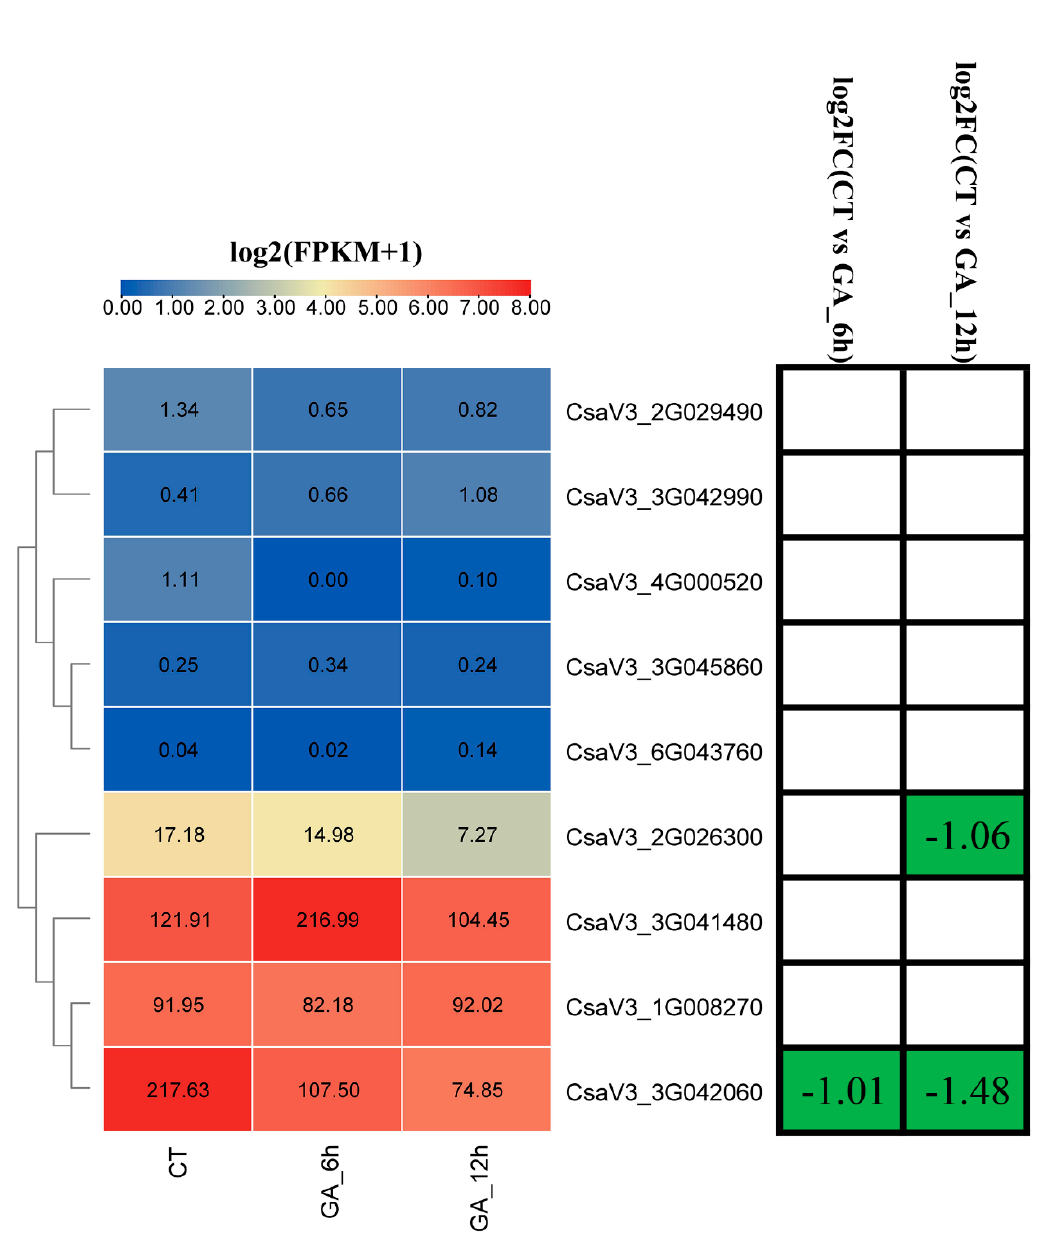
Figure 6. Expression heatmap of cucumber GASA family genes under GA treatment. CT: control treatment; GA_6 h: GA treatment for 6 h; GA_12 h: GA treatment for 12 h. The data in the left boxes indicate the original FPKM values. The data in the right boxes are log2(fold-change) values highlighted by red (up-regulation) and green (down-regulation) colors.